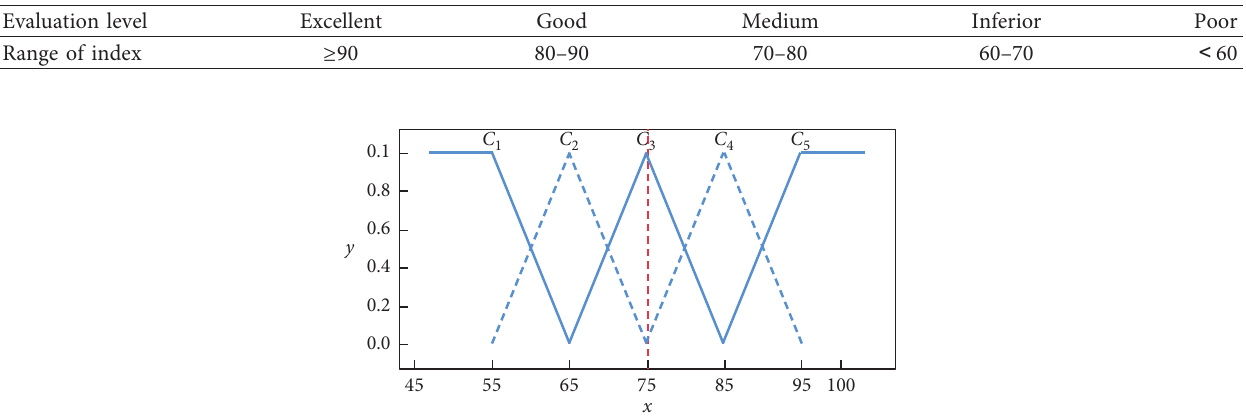
Figure 2: Distribution of unconfirmed measure functions. (a) Sinusoidal curve; (b) quadratic parabolic curve; (c) left-half trapezoidal curve; and (d) S-type curve. Table 1: Evaluation standard of highway technical condition.